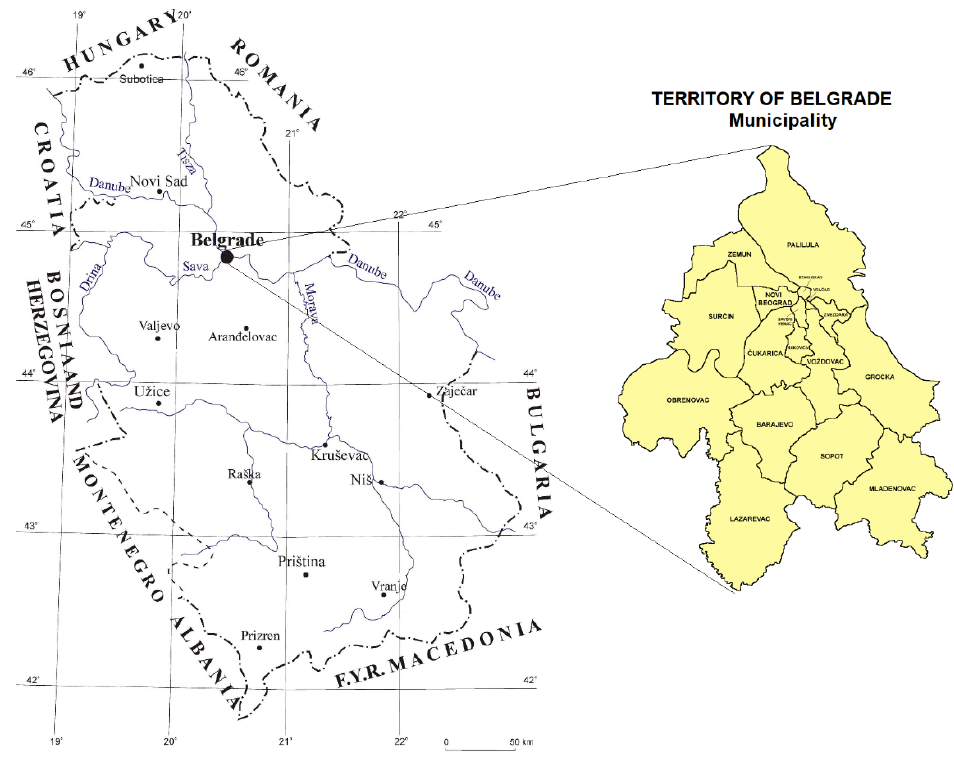
Figure 1. The territory of Belgrade (https://www.zdravlje.org.rs/ekoatlas/volbe/02ev.gif, accessed on 11 August 2020).